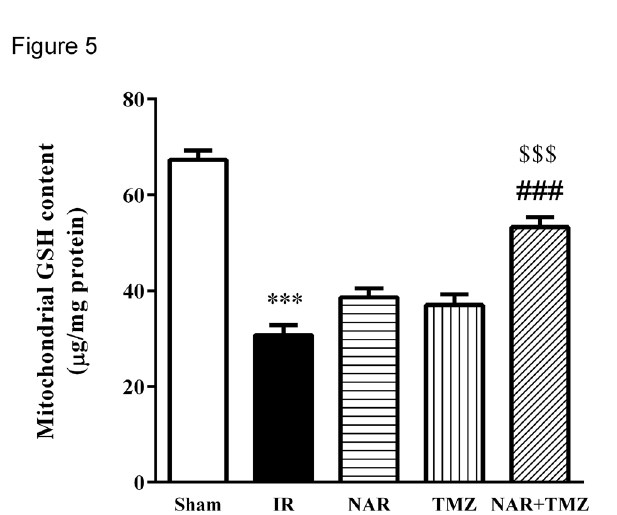
FIGURE 5 - Effect of Naringin (NAR) and Trimetazidine (TMZ) or their combination pretreatment on mitochondrial GSH content following renal IR injury (mean ± SEM